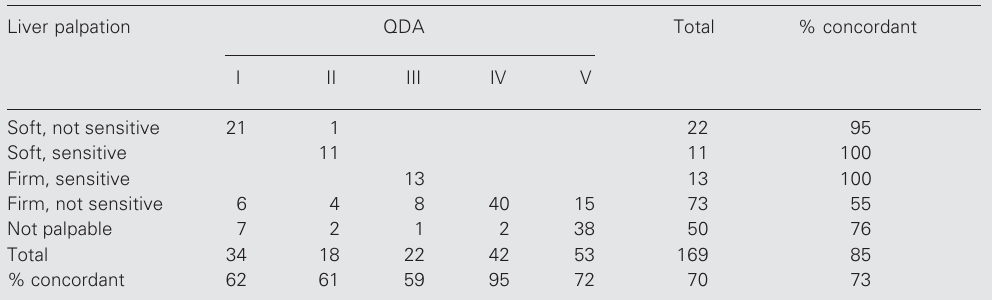
Table 2. Classification of liver disease in asymptomatic or oligosymptomatic alcoholics by liver palpation and multiple quadratic discriminant analysis (QDA) applied to some quantitative